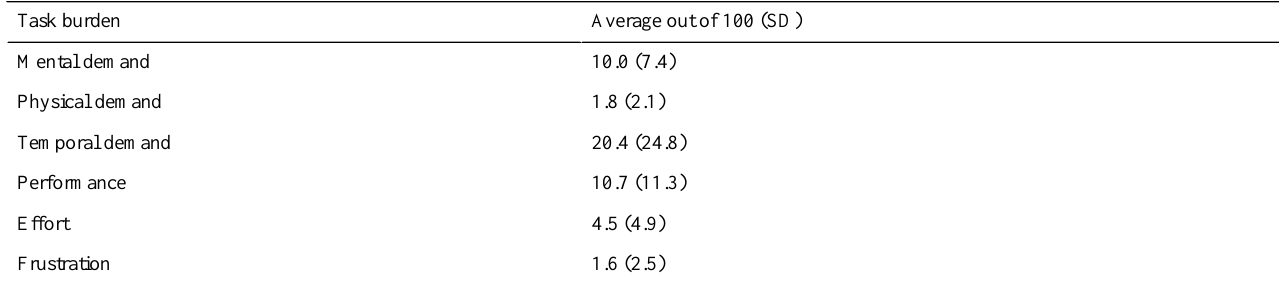
Table 5. The task burdens measured by the NASA Task Load